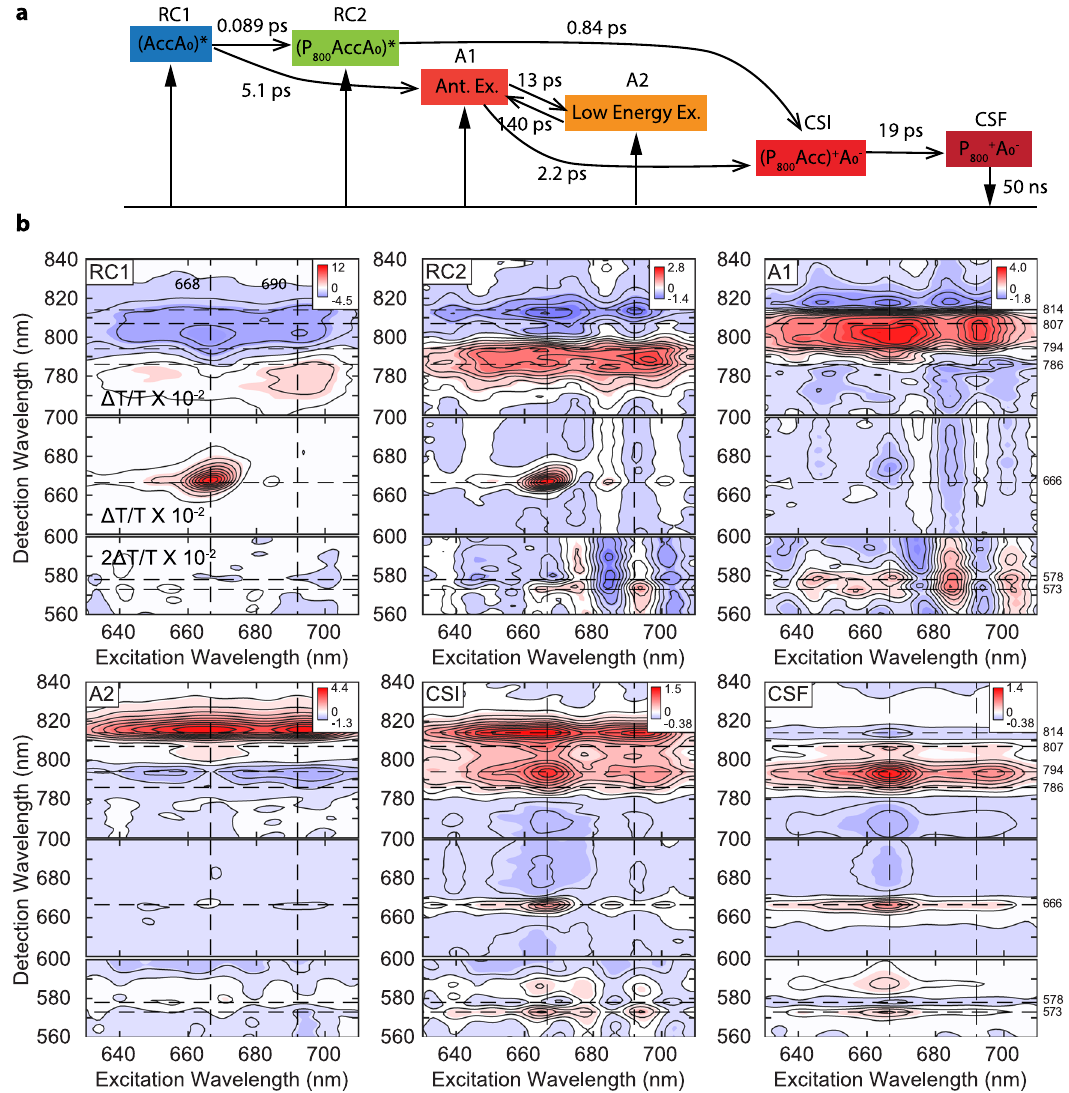
Fig. 3 Target analysis of the HbRC reveals the kinetic map and insights into the participating states during CS. a The kinetic model in which CS proceeds via a two-step mechanism with A 0 as the primary electron acceptor, independent of whether the initial excitation occurs within the RC or antenna domains. The vertical arrows indicate species that can be generated by direct photoexcitation. b The species-associated spectra obtained from the global- target analysis. The dashed lines in SASs indicate various peak positions as shown in Figs. 1 – 2 and discussed in the main text. The contour levels are − 1:0.1:1 of the maximum